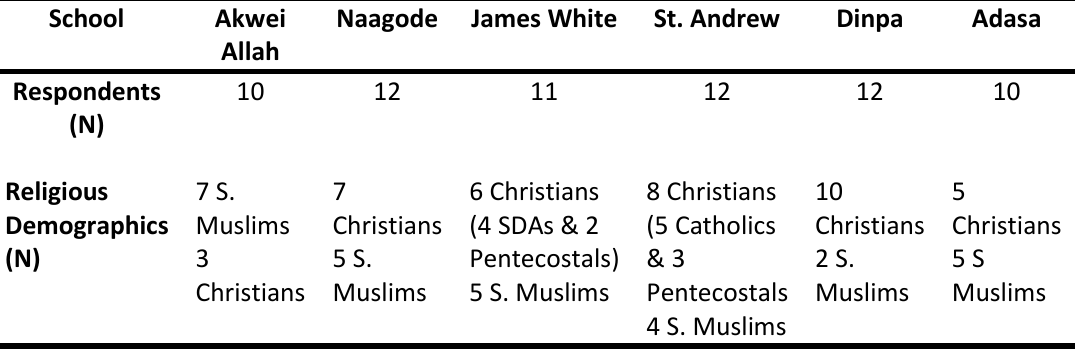
* S. Muslims (Sunni